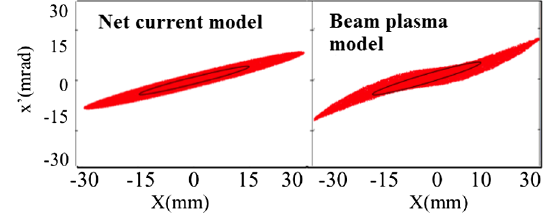
FIG. 5. Beam phase space from the 0.7 m drift simulation, using the net current model of space charge compensation at 80% (left) and secondary ions to compensate the beam (right).